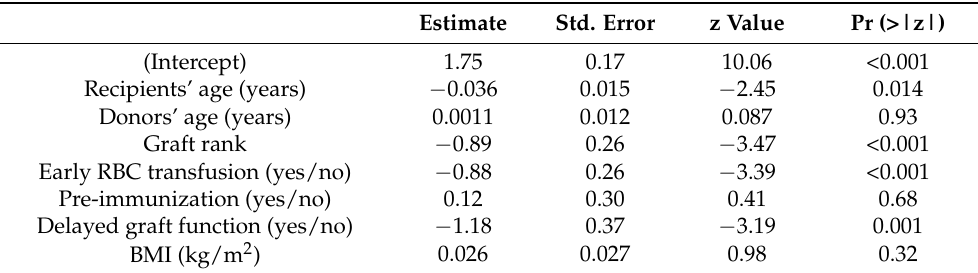
Figure 2. Barplot of chronic lesions (cv, IF/AT as the ci + ct score) among all available biopsies with a detailed Banff score ( n = 312). Table 2. Propensity score details. The last column gives the statistical significance of the parameter in the propensity